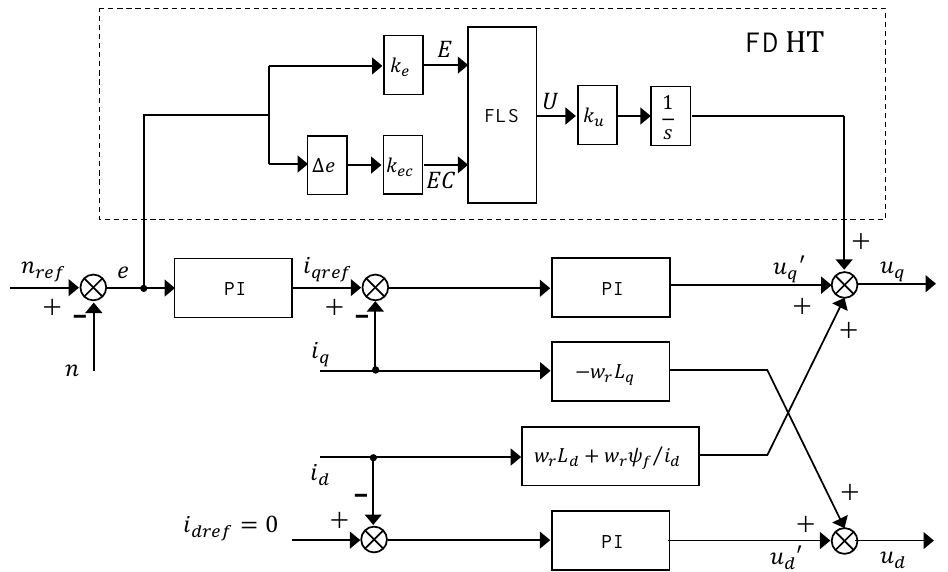
Figure 7. Structure of FDHT based on feed-forward decoupling